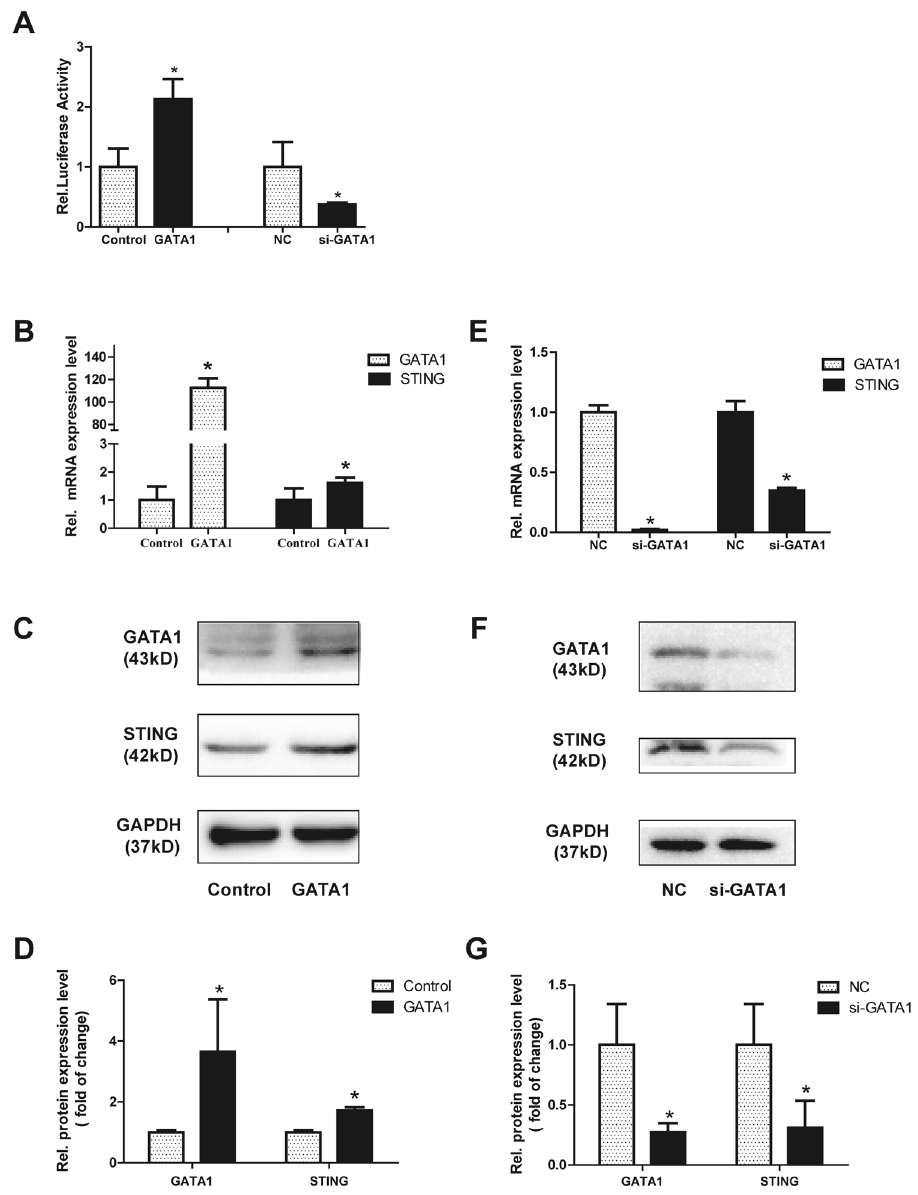
Figure 4. Effect of GATA1 on promoter activity of the mSTING gene. ( A ) Expression of the exogenous GATA1 increased the luciferase reporter gene activity of STING and knockdown of the endogenous GATA1 decreased the promoter activity. NIH3T3 cells were cotransfected with plasmids GATA1 or pcDNA 3.1( + ) (200 ng), GATA1 siRNA or negative control siRNA (50 nM) and pSTING-254 (100 ng), pRL-TK (3 ng). Luciferase assays were performed after 24 h. ( B – D ) The mRNA and protein levels of mSTING were significantly increased after GATA1 overexpression. qRT-PCR and western blot were performed after GATA1 plasmid or pcDNA 3.1( + ) were transiently cotransfected into NIH3T3 cells. The protein expression was quantified to GAPDH. Each bar represented the mean ± SD of three independent experiments (n = 3, * P < 0.05 vs. Control). ( E – G ) Knockdown of GATA1 by siRNA (50 nM) reduced the mRNA and protein level of mSTING. The protein expression was quantified to GAPDH. siRNA negative control was set as 1. Each bar represented the mean ± SD of three independent experiments (n = 3, * P < 0.05 vs.